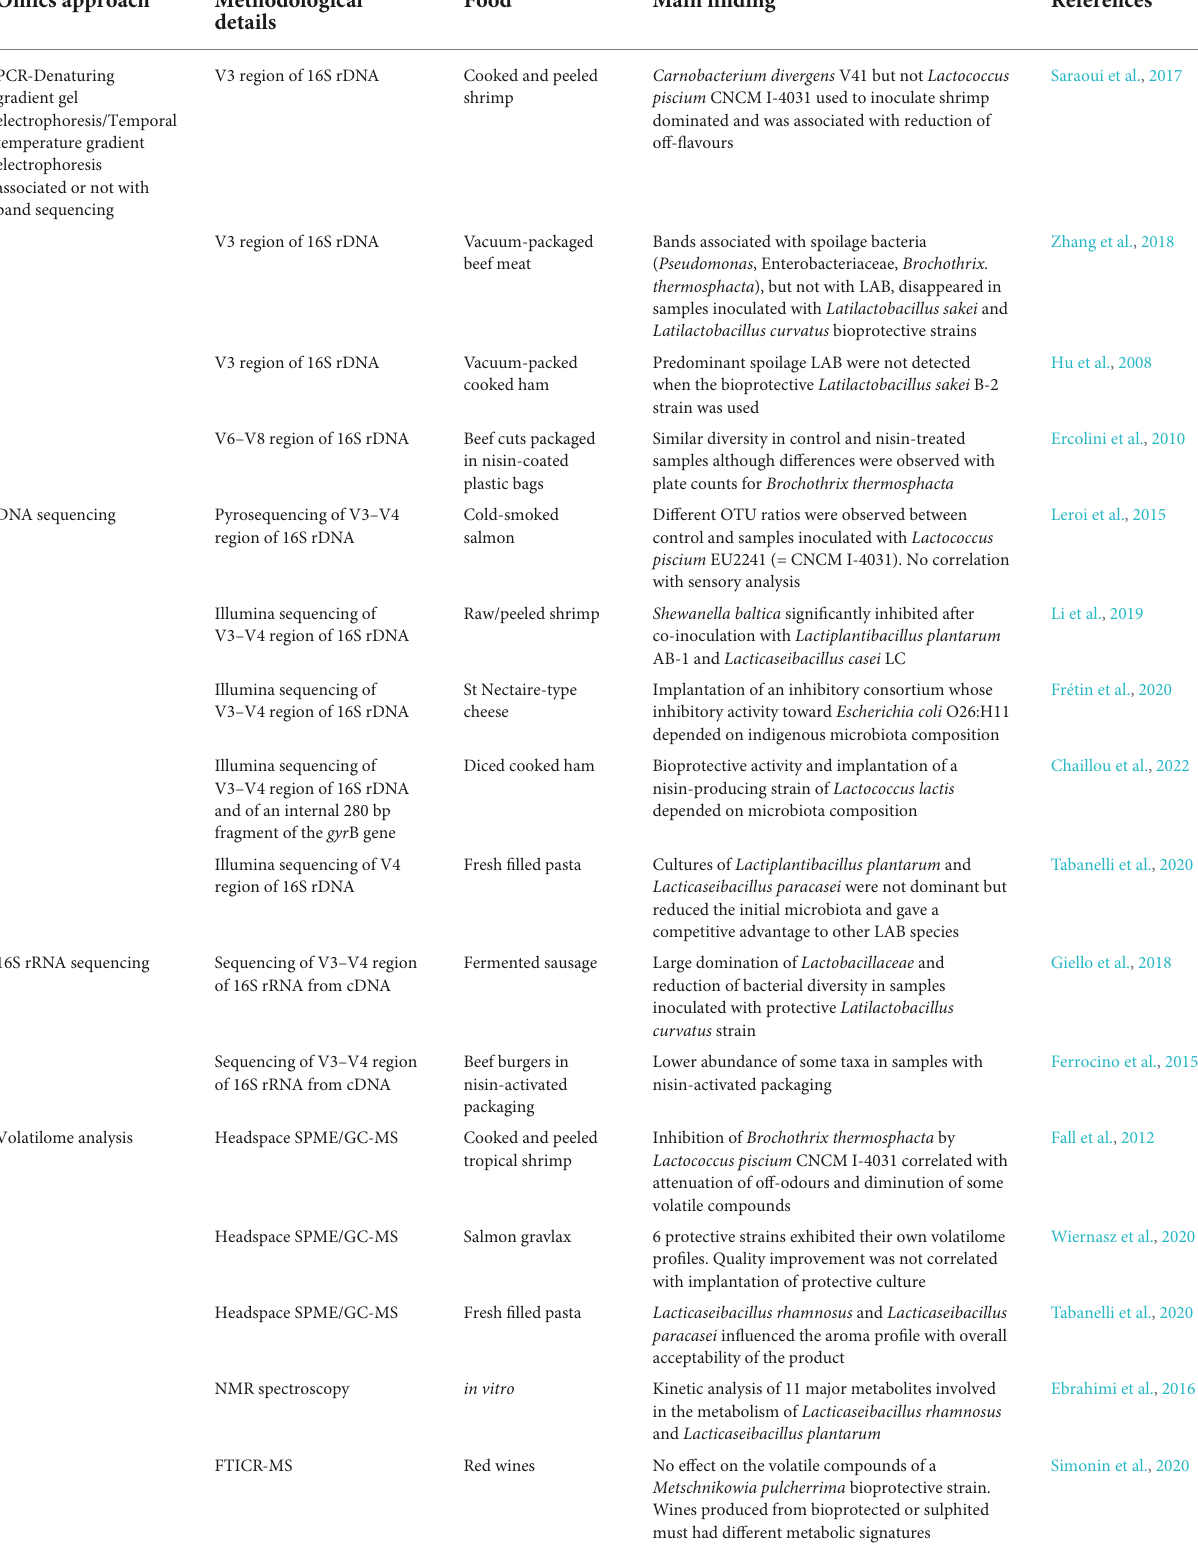
TABLE 2 Overview of omics approaches used to assess the impact of biopreservation on food ecosystems and main